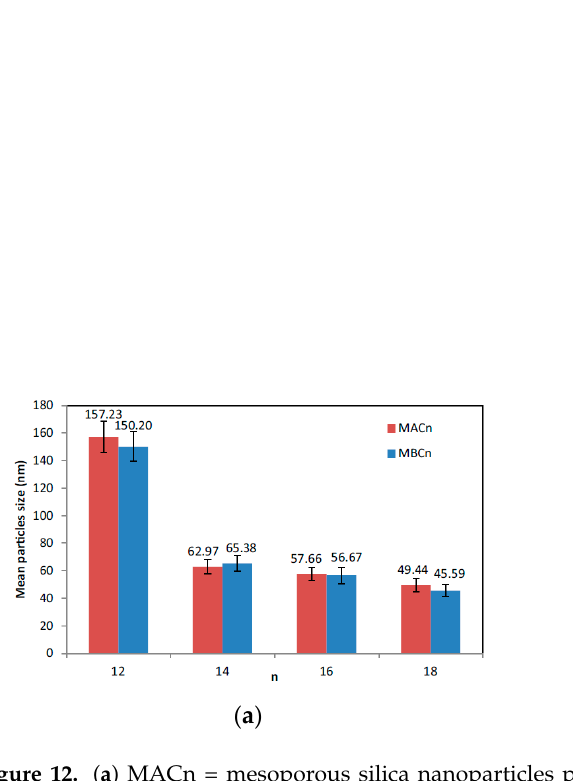
Figure 12. ( a ) MACn = mesoporous silica nanoparticles prepared by strategy (i) and ( b ) MBCn = mesoporous silica nanoparticles prepared by strategy (ii) [198]. Reprinted with permission from ref. [198]. Copright 2021